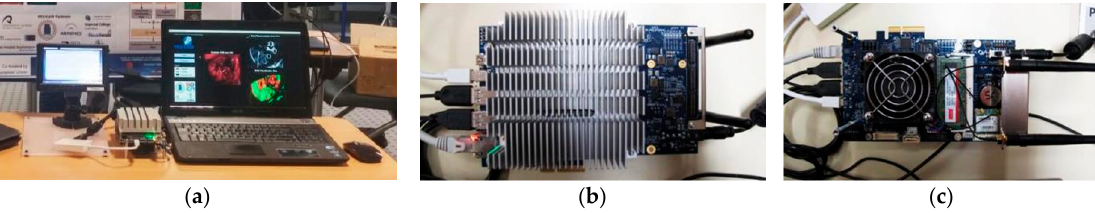
Figure 5. The Kalray MPPA ® EMB01 Platform: ( a ) Developer environment; ( b ) EMB01 top view where the host module is located; ( c ) EMB01 bottom view where the carrier board is placed.